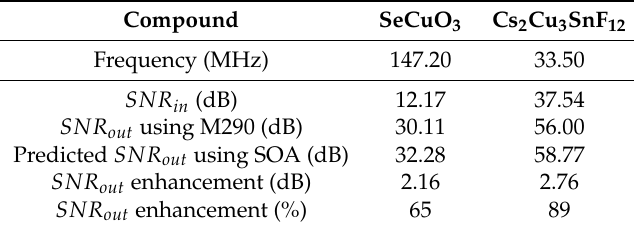
Table 4. Results of SNR in prediction of NMR receiving chain using